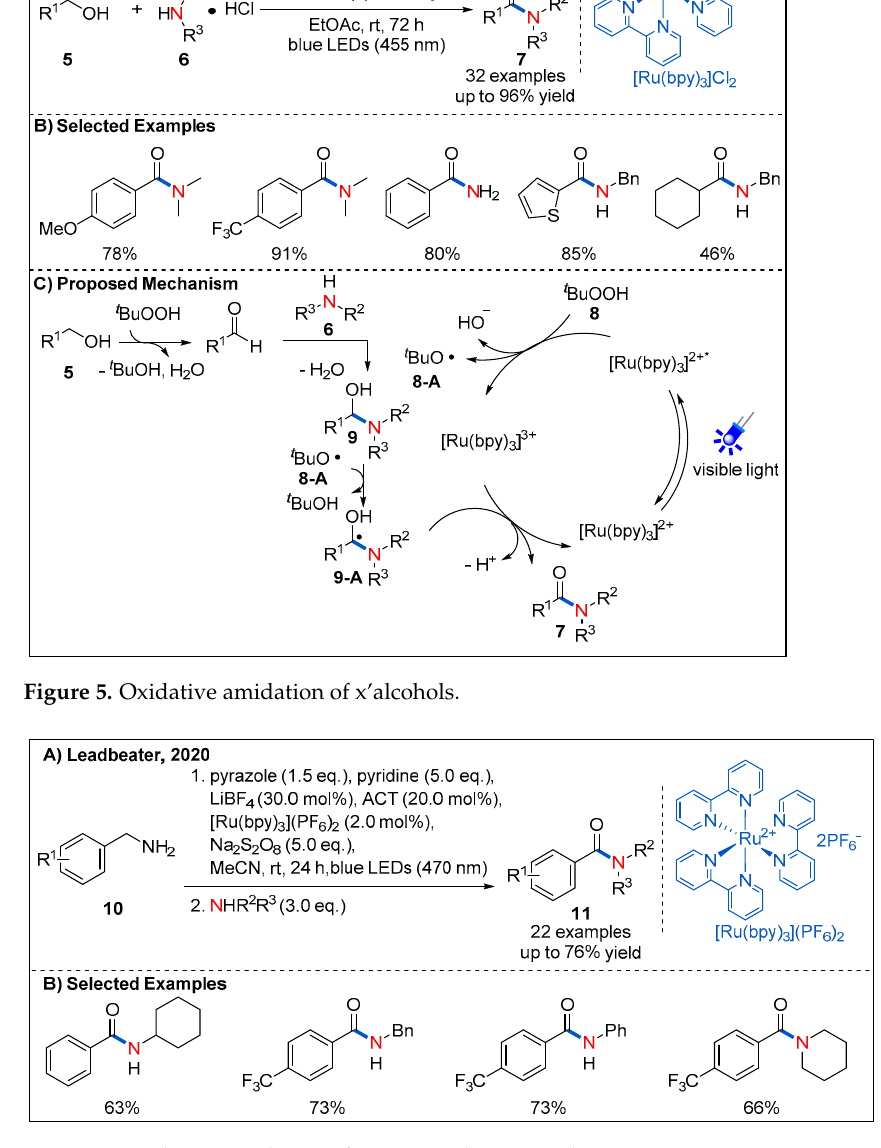
Figure 6. Oxidative amidation of amines and transamidation.